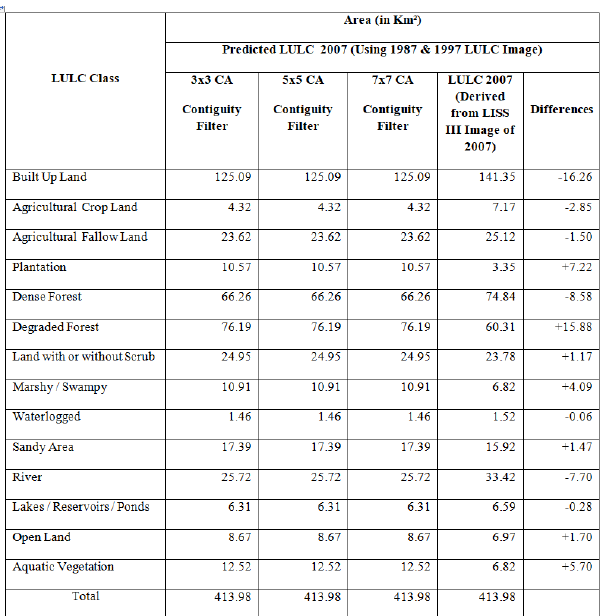
Table 4. Area statistics of predicted LULC of 2007 using 1987 & 1997 LULC image and LULC derived from LISS III image of 2007